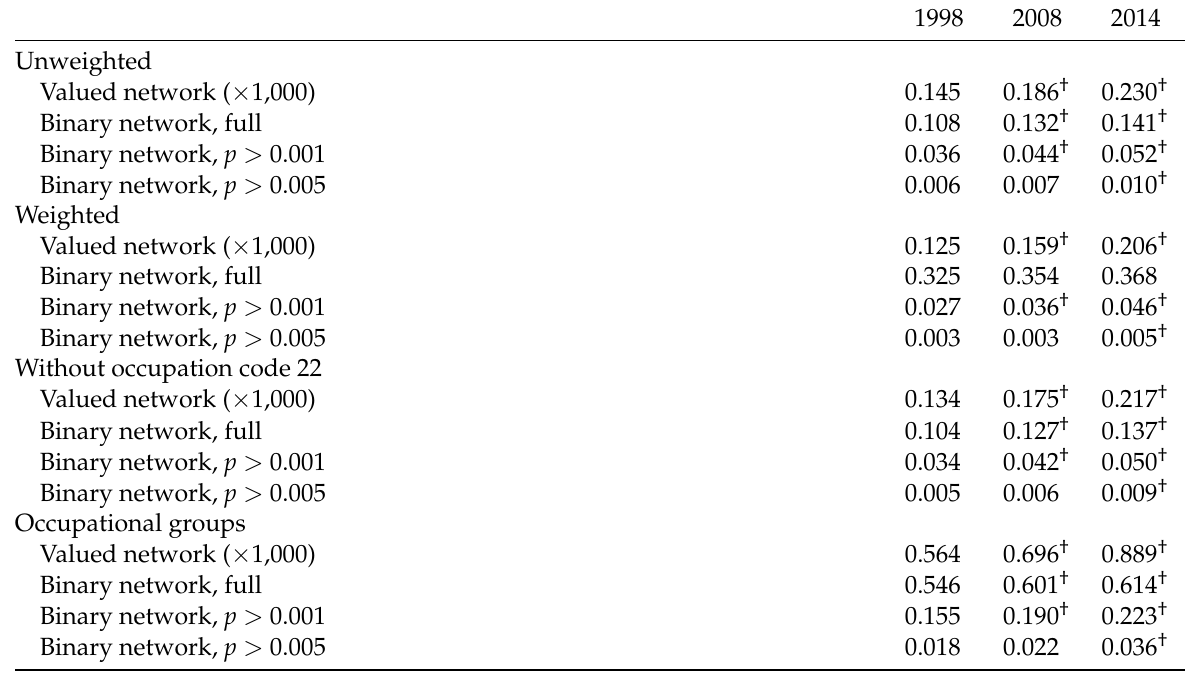
Table 1: Network density for all men, 1998 to